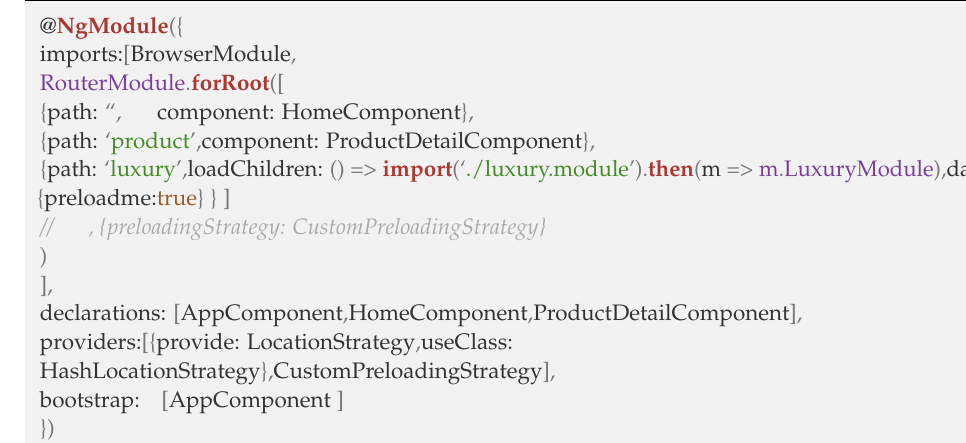
Algorithm 5: NgModule —Outline the decision mode in Angular for lazy loading in the